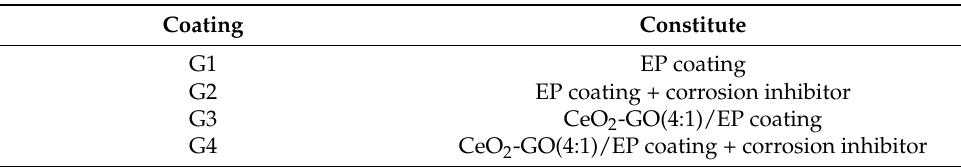
Table 2. The coating conditions of G1, G2, G3, and G4.